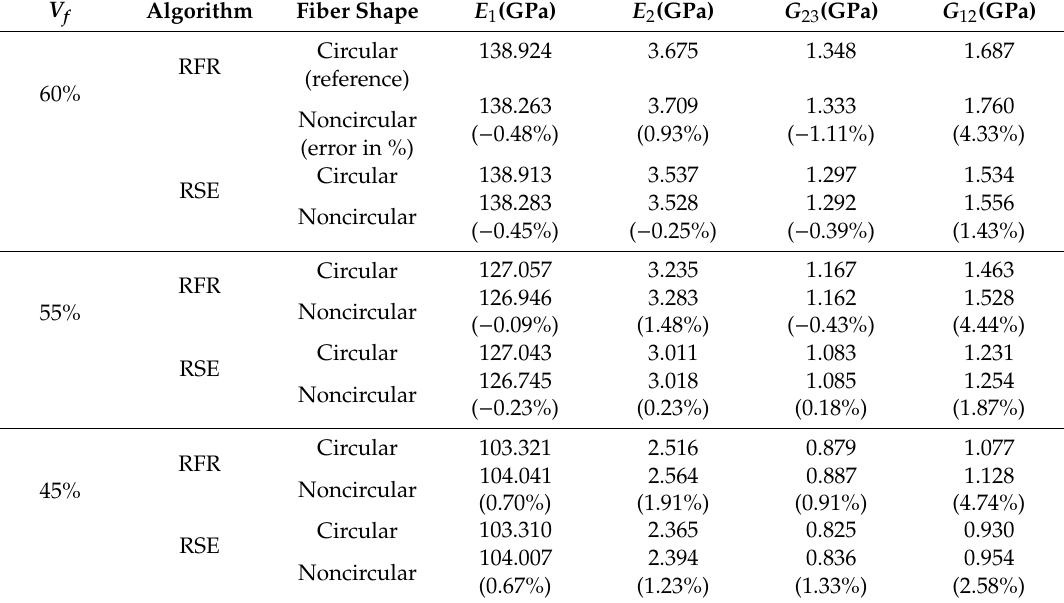
Table 5. Comparison of the e ff ective elastic properties of T300 /